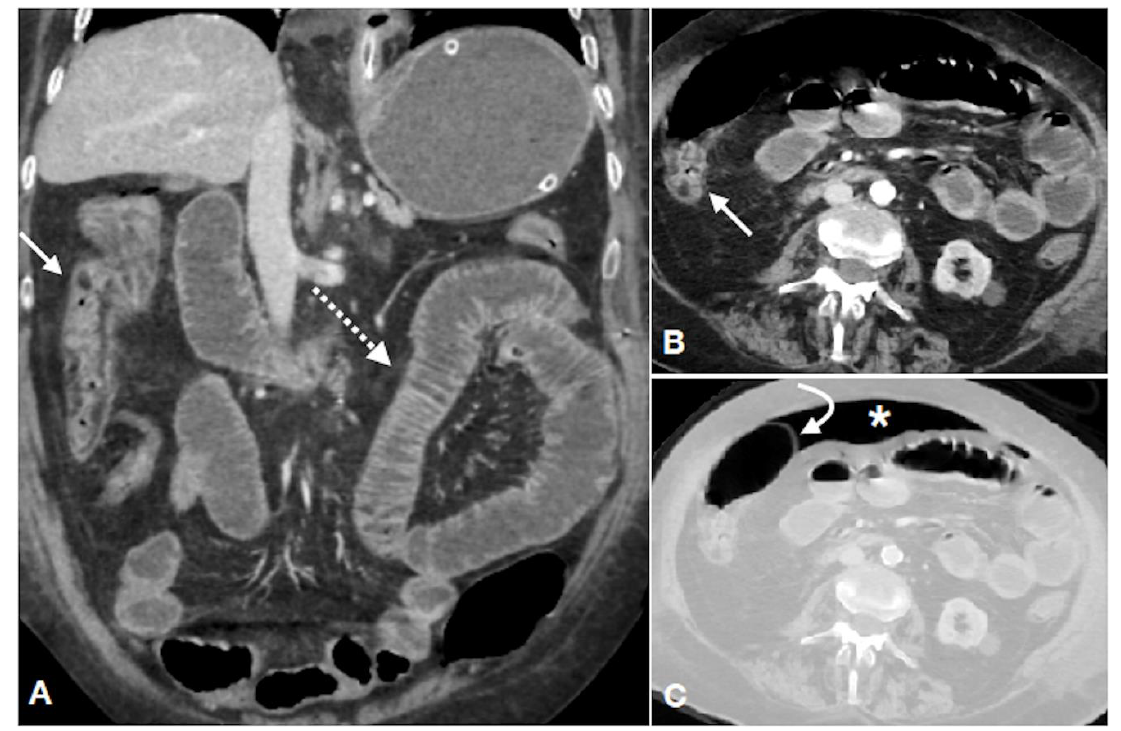
Figure 2. CT of an 85-year-old female with pelvis fracture, complaining of abdominal pain and constipation. Enhanced CT in portal-venous phase, coronal ( A ) and axial ( B , C ) views, showing thickening of the ascending colonic wall with mucosal hyperemia and submucosal edema (( A , B ) arrow) and increased enhancement of the small bowel wall (( A ), dotted arrow); these are findings of small and large bowel reperfusion after ischemia. The colonic wall is partly thickened (( B ), straight arrow), due to reperfusion phenomena, and partly thinned and distended (( C ), curved arrow), due to ischemia without reperfusion, leading to colonic perforation with peritoneal free air (( C ), asterisk).